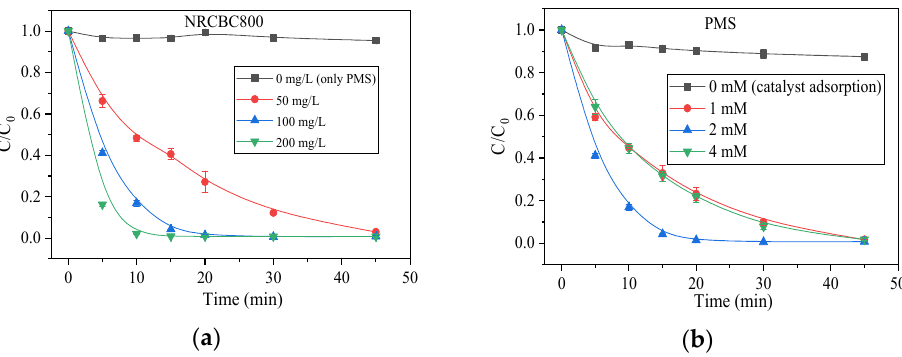
Figure 3. Influences of NRSBC800 dose ( a ) and PMS dose ( b ). Condition: in ( a ), [catalyst] = 50–200 mg/L and [PMS] = 614 mg/L = 2 mM; in ( b ), [catalyst] = 100 mg/L, [PMS] = 1–4 mM; and [AO7] = 50 mg/L and T = 25 °C.